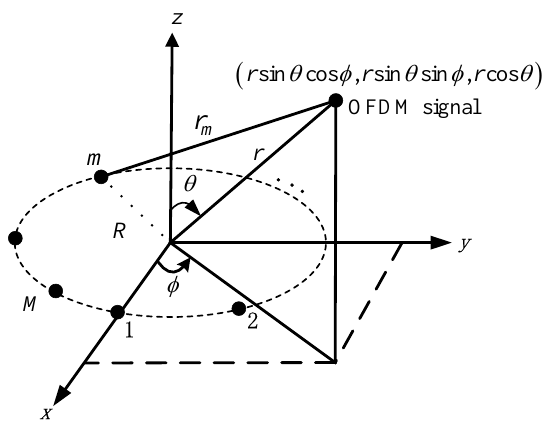
Figure 2. Geometry of a UCA with a near-field OFDM signal.